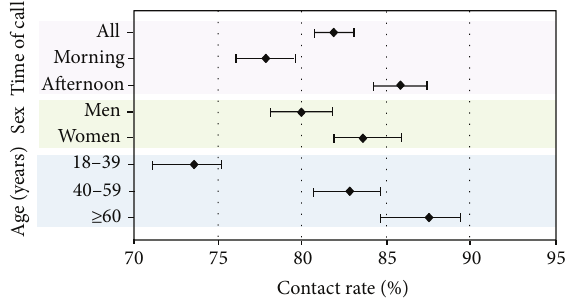
Figure 1: Contact rate broken down by time of call, sex, and